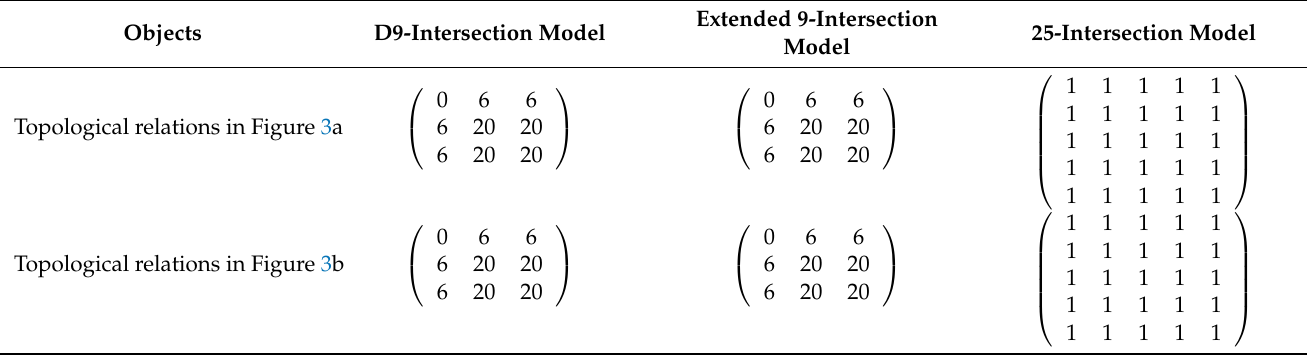
Figure 3. Two types of overlaps between regions with holes. ( a ) A overlaps B , and H a is disjointed from H 1 ; ( b ) A overlaps B , and H a overlaps H 1 . Table 1. Results of two types of overlaps between regions with holes using three kinds of topological representation models.